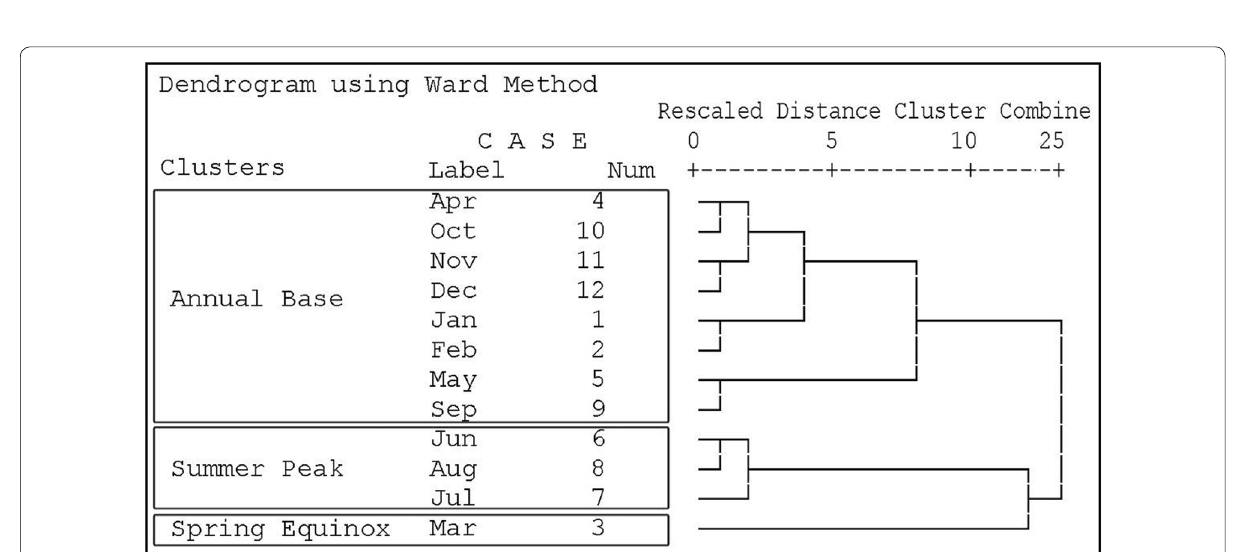
Fig. 5 Clustering dendrogram of the months based on traffic flow, extracted from HCA method in SPSS